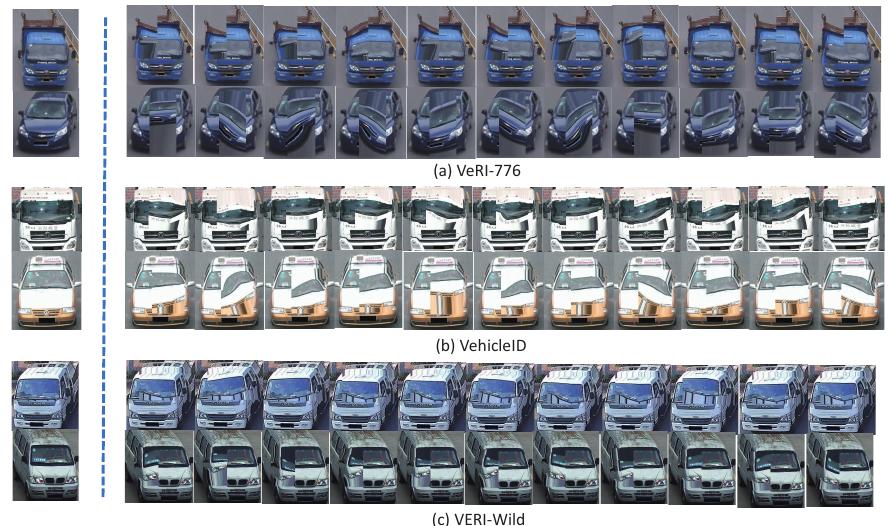
Figure 10. Visualization of the Input Images and the Eleven Augmented